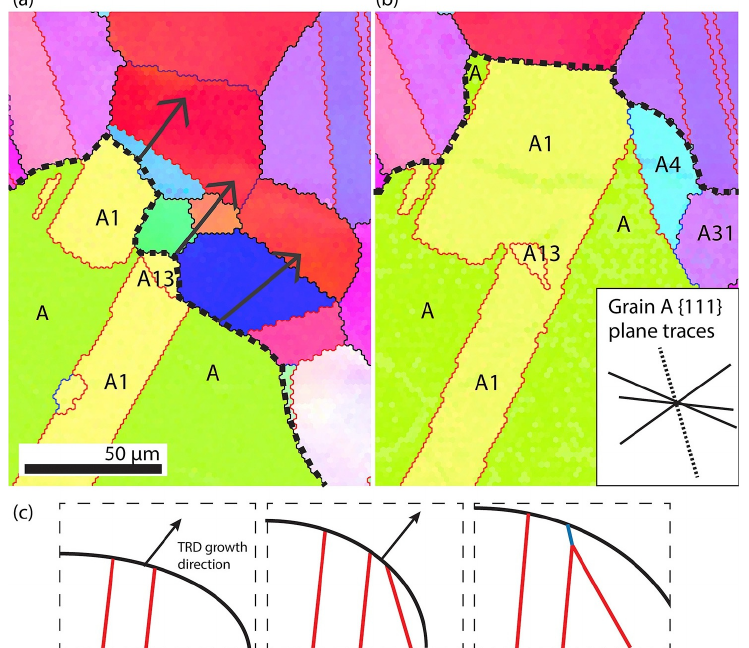
Figure 2. ( a , b ) Evolution of the twin cluster during the annealing process, where the dashed line indicates the interface between the existing twin cluster and the deformed matrix; ( c ) schematic of the formation of the AT boundary during the evolution of the twin cluster front and the formation of Σ 9 GB (the inset illustrates the 111 plane trace for the growing grain (A). adopted from Ref. [36].